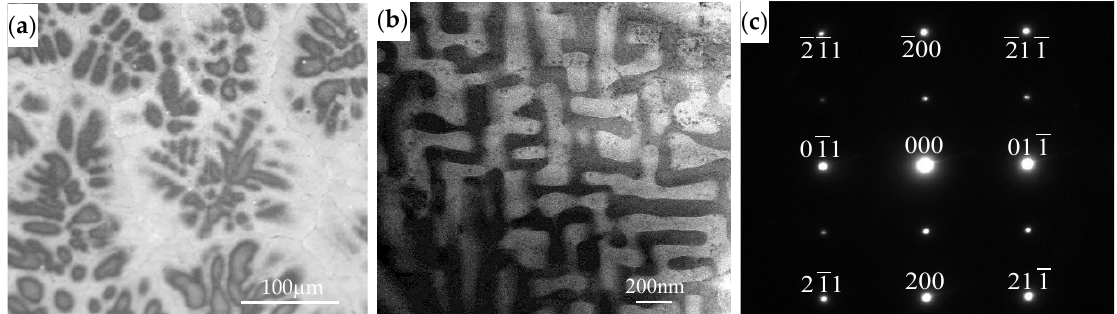
Figure 4. Metallograph ( a ) and TEM bright-field image ( b ) as well as corresponding selected area electron diffraction patterns ( c ) of the Zr0 alloys.